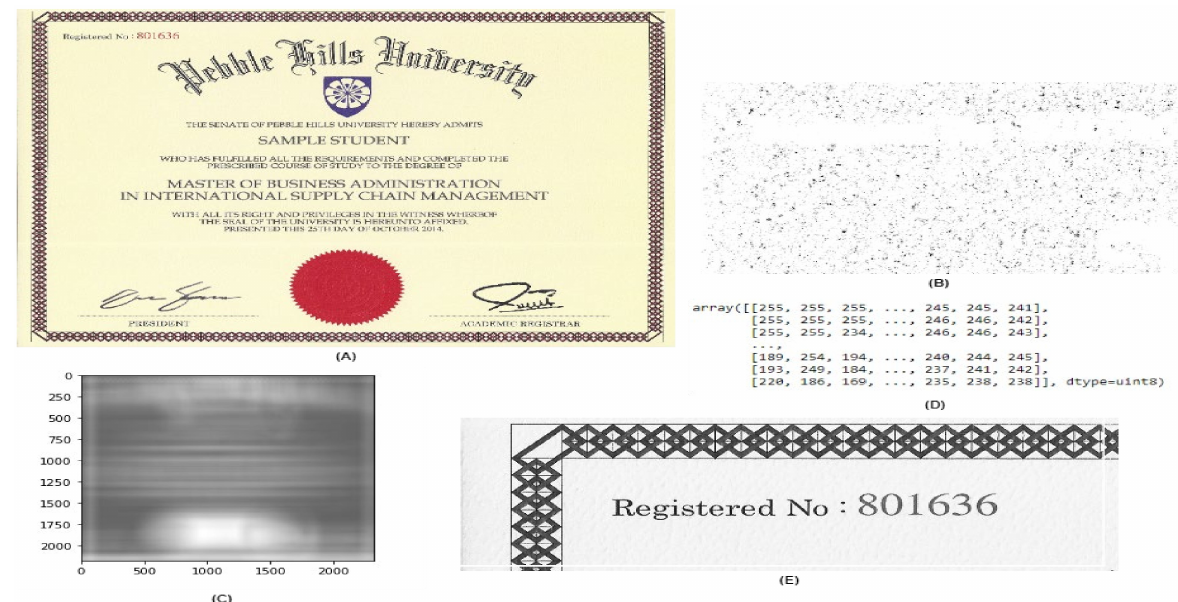
Figure 5. Simulation results of the proposed accreditation model. ( A ) Input image, ( B ) encode to identify tampering, ( C ) convert into grayscale to fine trace, ( D ) image matrix, and ( E ) output to check individual